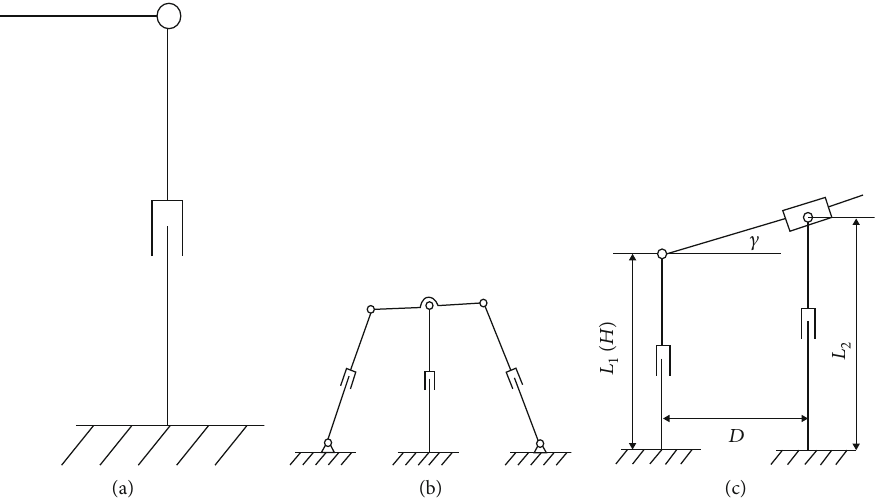
Figure 5: Three 2-DoF mechanisms that can realize adjustment of height and inclination.